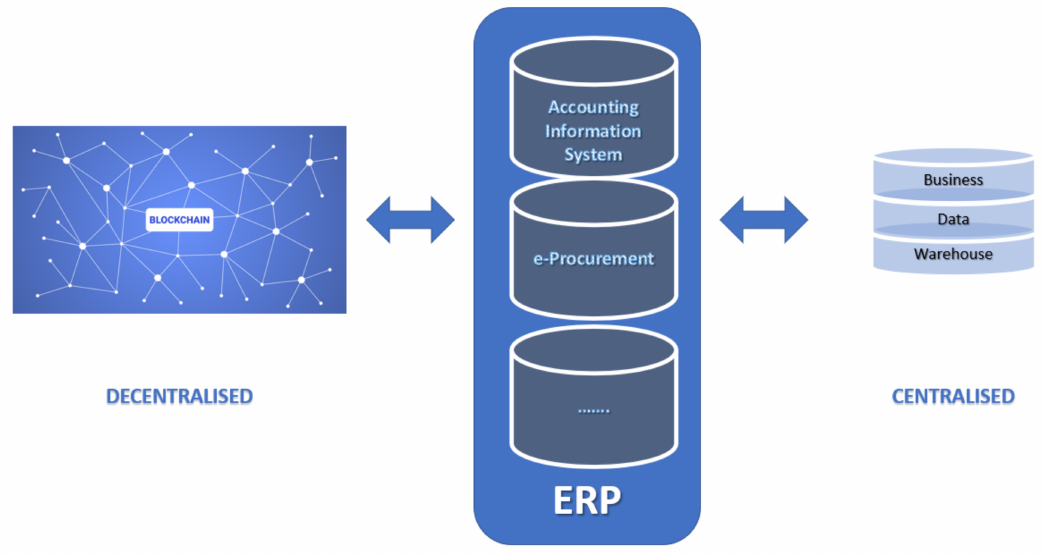
Figure 5. The ERP system pivotal